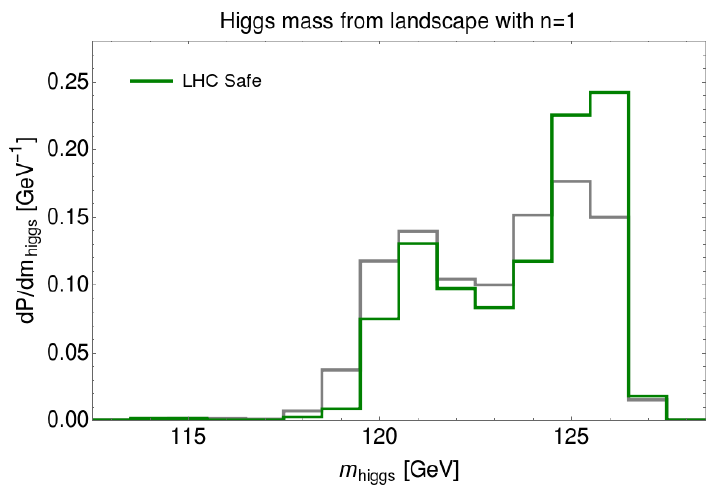
Figure 2. Statistical expectation for the mass of the Higgs boson from the string theory landscape which scans over single F -term SUSY breaking. The green histogram includes only LHC Run 2 safe